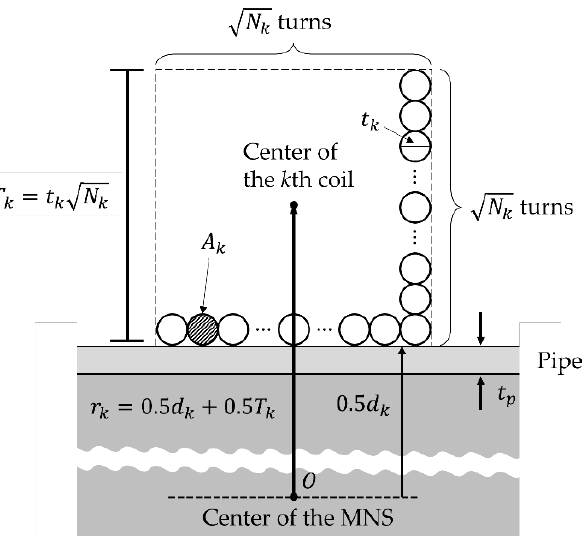
Figure 3. The design variables and parameters of the k -th coil. This cross-section shows the case in which the coil is attached to the outside of the pipe.